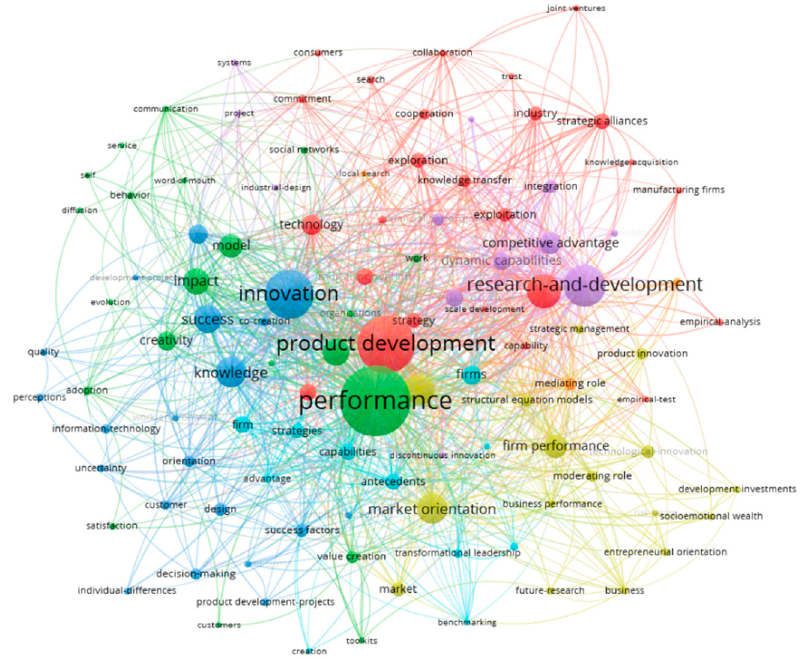
Figure 6. VOS Viewer: keywords from the Journal of Product Innovation Management. There were eight clusters detected in this journal; the total number of keywords was 345.